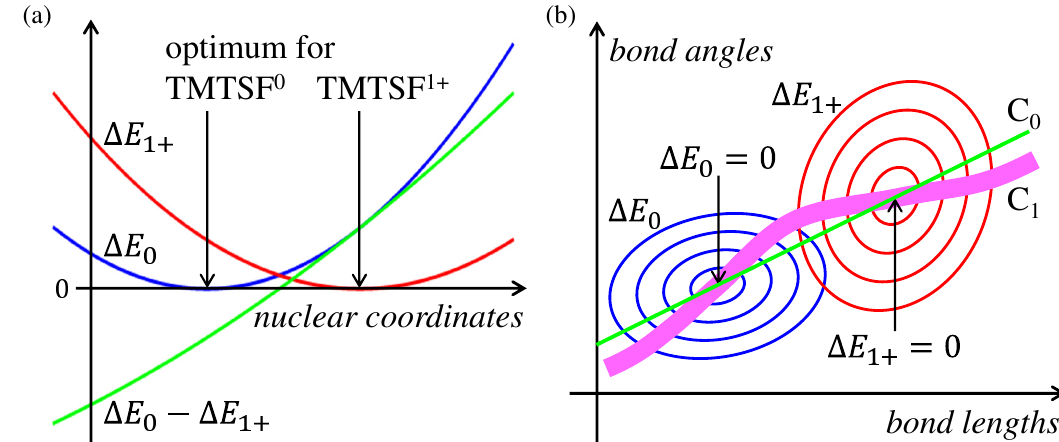
Figure 11. ( a ) Schematic image of ∆ E 0 (red), ∆ E 1 + (blue), and ∆ E 0 − ∆ E 1 + (green) as functions of the nuclear coordinates of a TMTSF molecule in a crystal. ( b ) Simplified images of ∆ E 0 and ∆ E 1 + as multidimensional paraboloids, which are the functions of bond lengths and bond angles of a TMTSF molecule in a crystal. The thin green line C 0 represents the path when the conformation changes continuously keeping the optimum one at each effective valence. In reality, the molecular conformations are not optimum in crystals, thus the molecules will be somewhere on the thick pink curve C 1 (see text). These relations are simply expressed by the ∆ E 0 − ∆ E 1 + . The energy increase ∆ E 0 and ∆ E 1 +